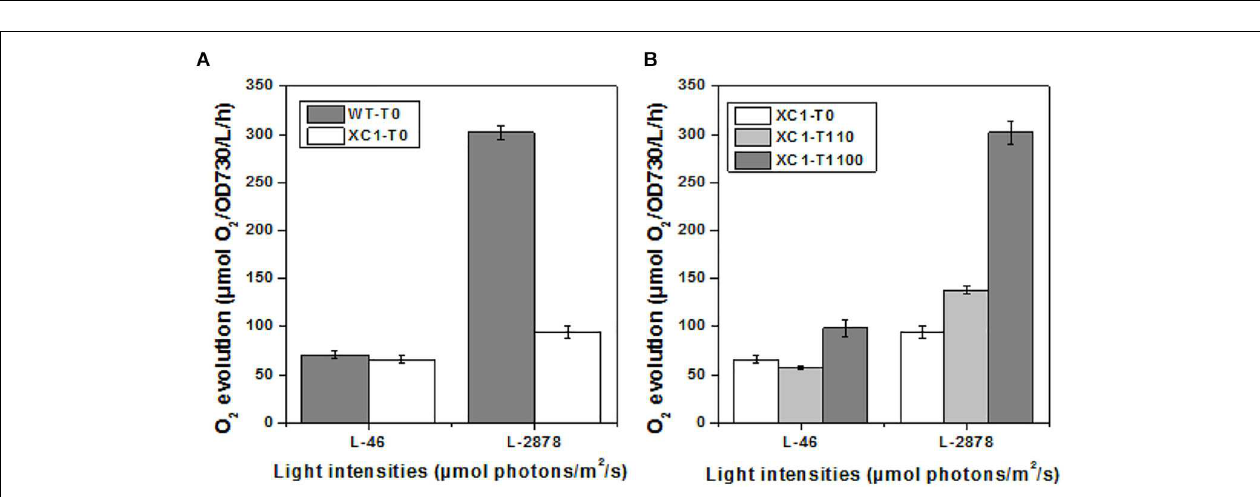
FIGURE 3 | Growth assays of PCC7942-WT and PCC7942-XC1 under induction of gradually increasing theophylline concentrations. (A) No theophylline was added; (B) 110 µ M theophylline was added; (C) 1100 µ M theophylline was added. Optical densities under 730 nm (OD730) were used to calculate cell concentrations. The data utilized are averages of measurements from at least three independent biological repeats, and the standard deviations bars are shown.